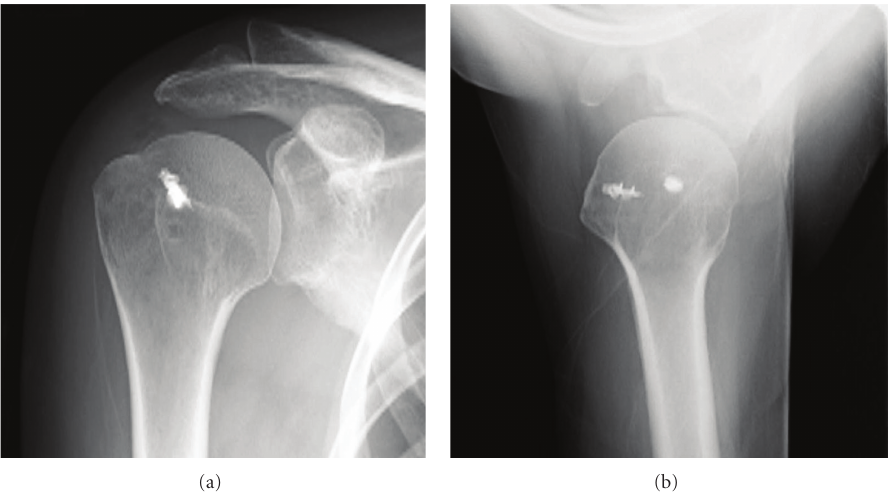
Figure 3: (a) and (b) Postoperative radiographs (anteroposterior view, axillary view) showing the subsidence of the calcific